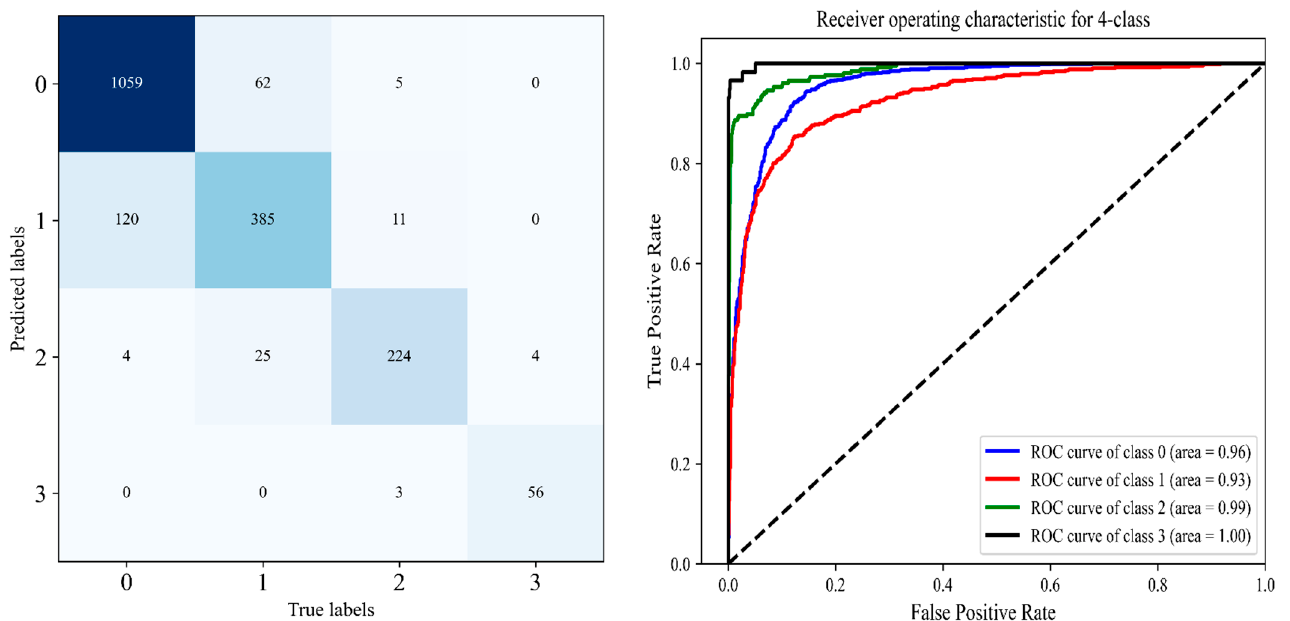
Figure 14. Left is the confusion matrix, and right shows the ROC curve obtained from DHL-II for classifying knee OA using four classes.